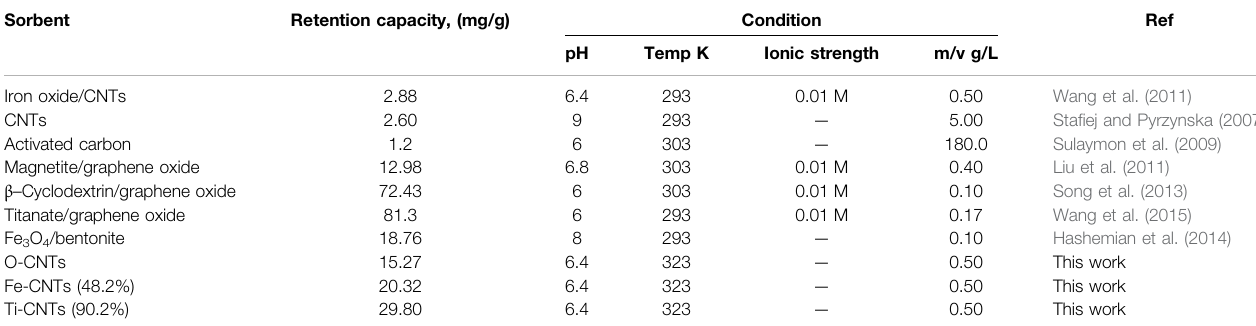
TABLE 2 | Comparison of Co retention of prepared nanocomposites and the previous studies in the literature. Sorbent